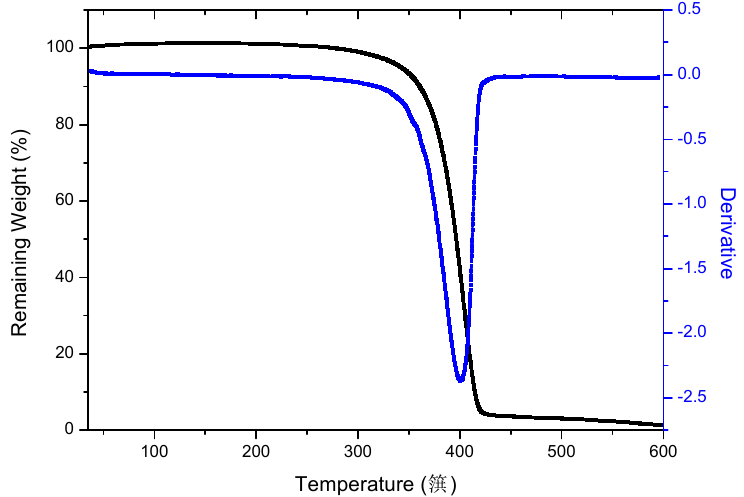
Figure 3. TGA thermograms of PBS_CL copolyester recorded under nitrogen atmosphere.